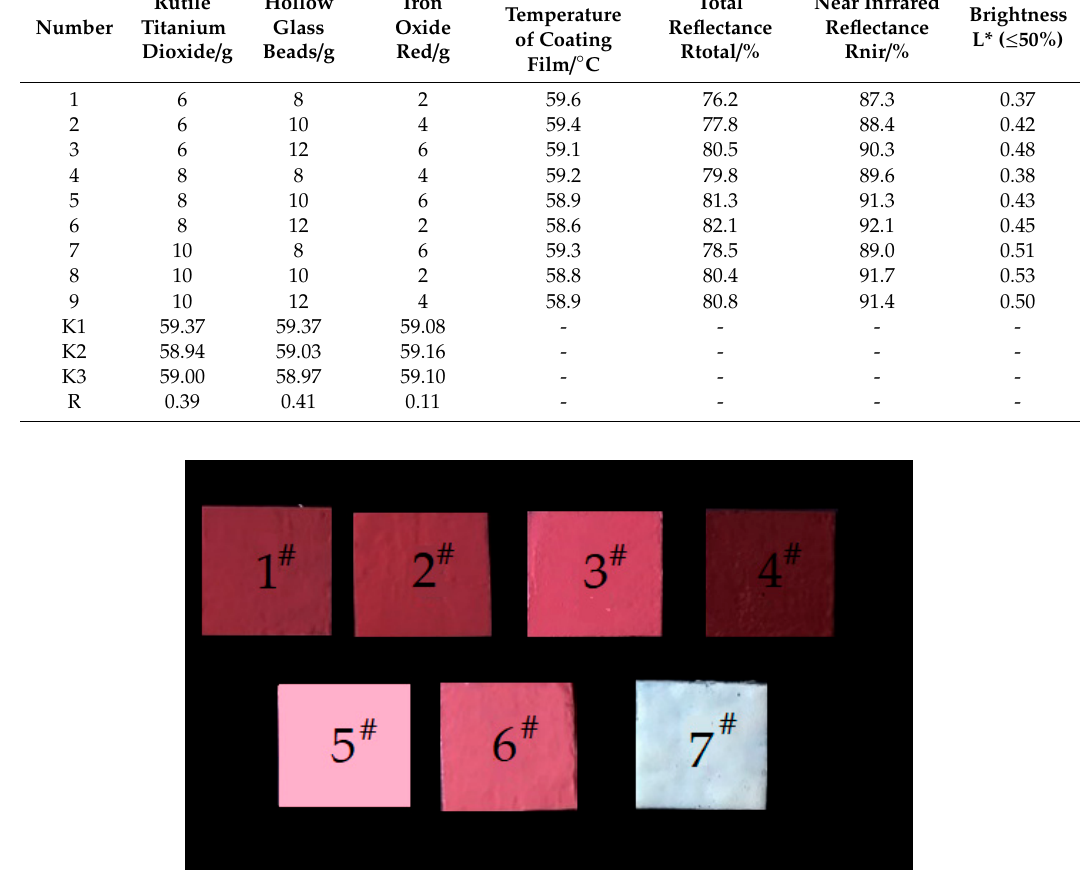
Table 2. Orthogonal experimental scheme of the coating filler formula and coating performance.